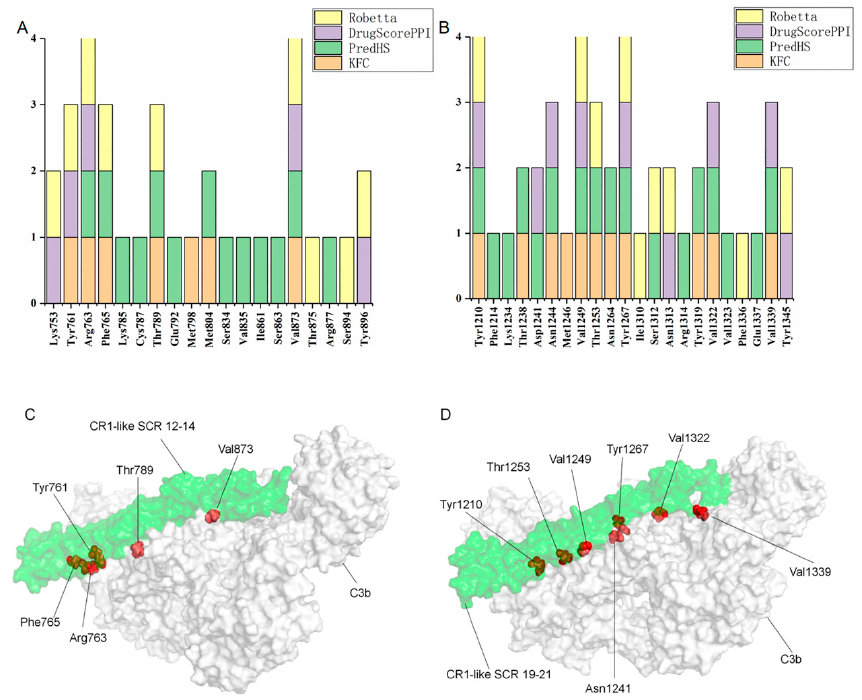
Figure 6. Prediction and demonstration of CR1-like hotspot residues. ( A ) Prediction of hotspot residues at the C3b–CR1-like SCR 12–14 binding interface by four prediction tools. ( B )